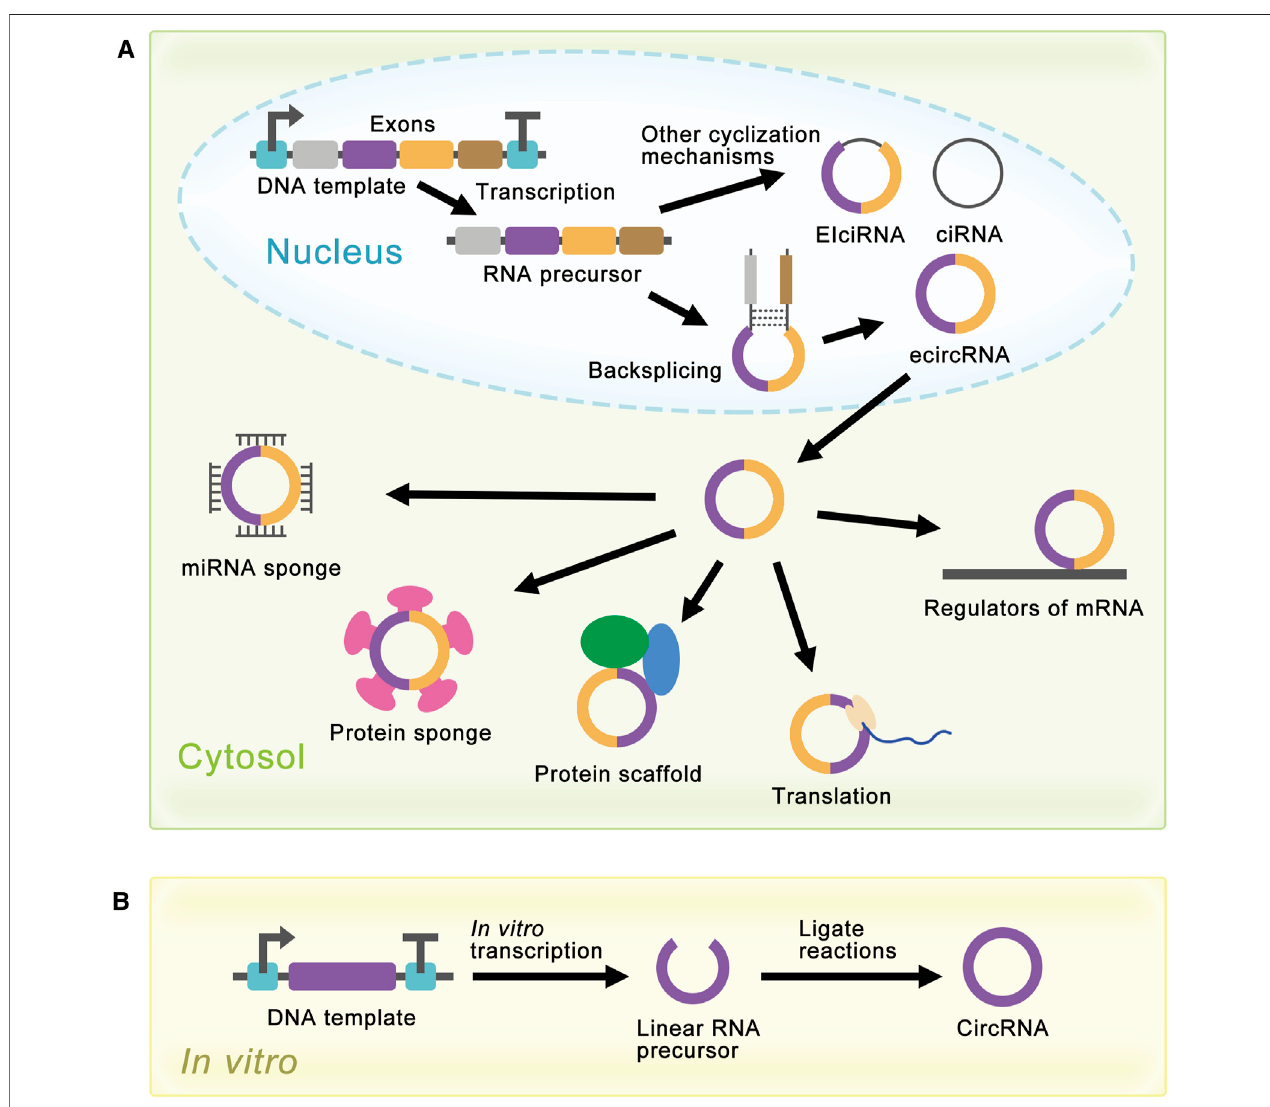
FIGURE 2 | Schematic diagram of circRNA synthesis in vivo and in vitro . (A) EcircRNAs are the major circRNAs and are mainly produced by a process called backsplicing in vivo . EIciRNAs and ciRNAs are produced by other cyclization reactions and located in the nucleus. EcircRNAs are mainly located in the cytoplasm and have various functions. In the cytosol, circRNAs can act as miRNA sponges, protein sponges, protein scaffolds, translation templates, and regulators of mRNA. (B) Linear RNA precursor is produced from in vitro transcription, and researchers have developed several methods for linear RNA precursor ligation to synthesize circRNA in vitro